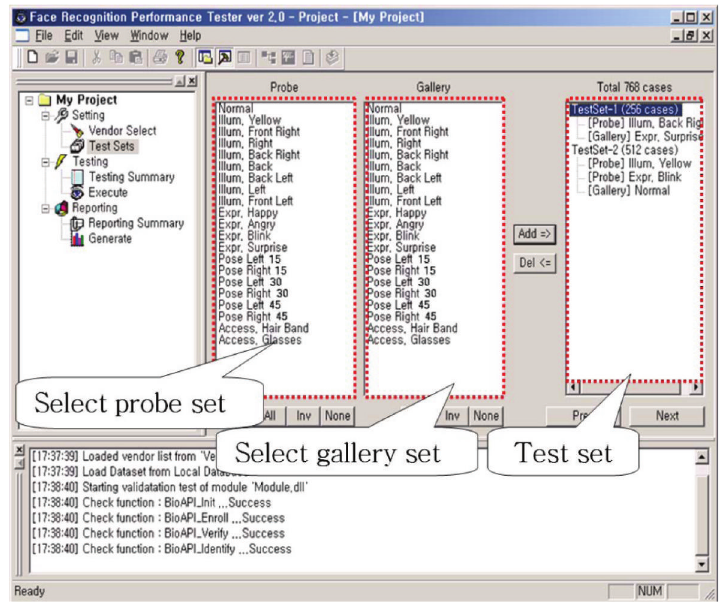
Figure 4: Selection window for face image probe set and gallery set.